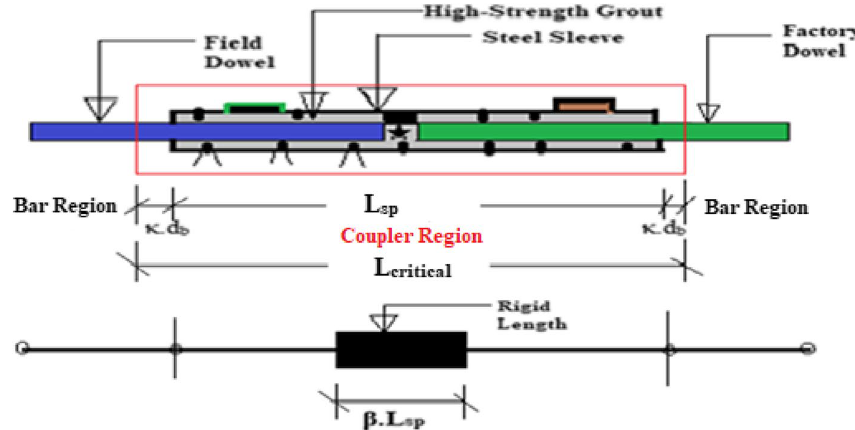
Fig. 19 Uniaxial stress-strain concentration in coupler